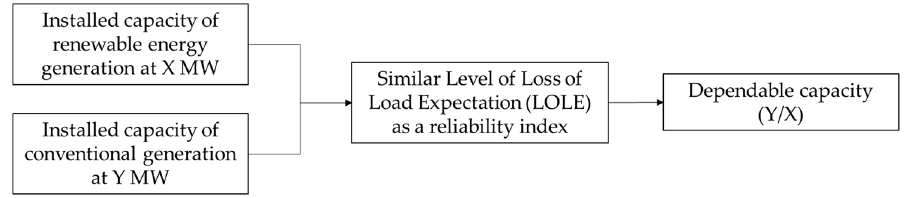
Figure 1. Concept of capacity credit evaluation.